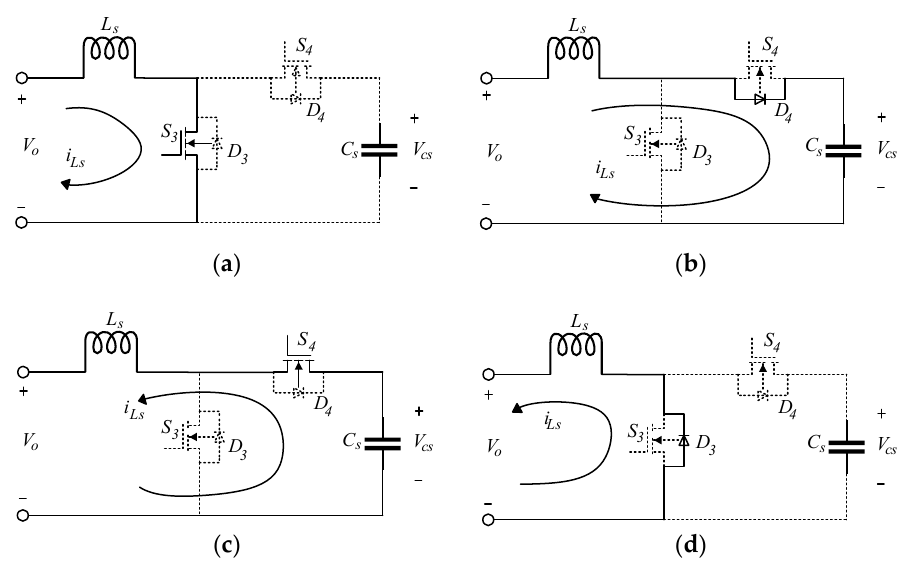
Figure 4. Working mode of the bidirectional buck/boost converter: ( a ) forward switching state; ( b ) forward continuation state; ( c ) reverse switching state; ( d ) reverse continuation state.